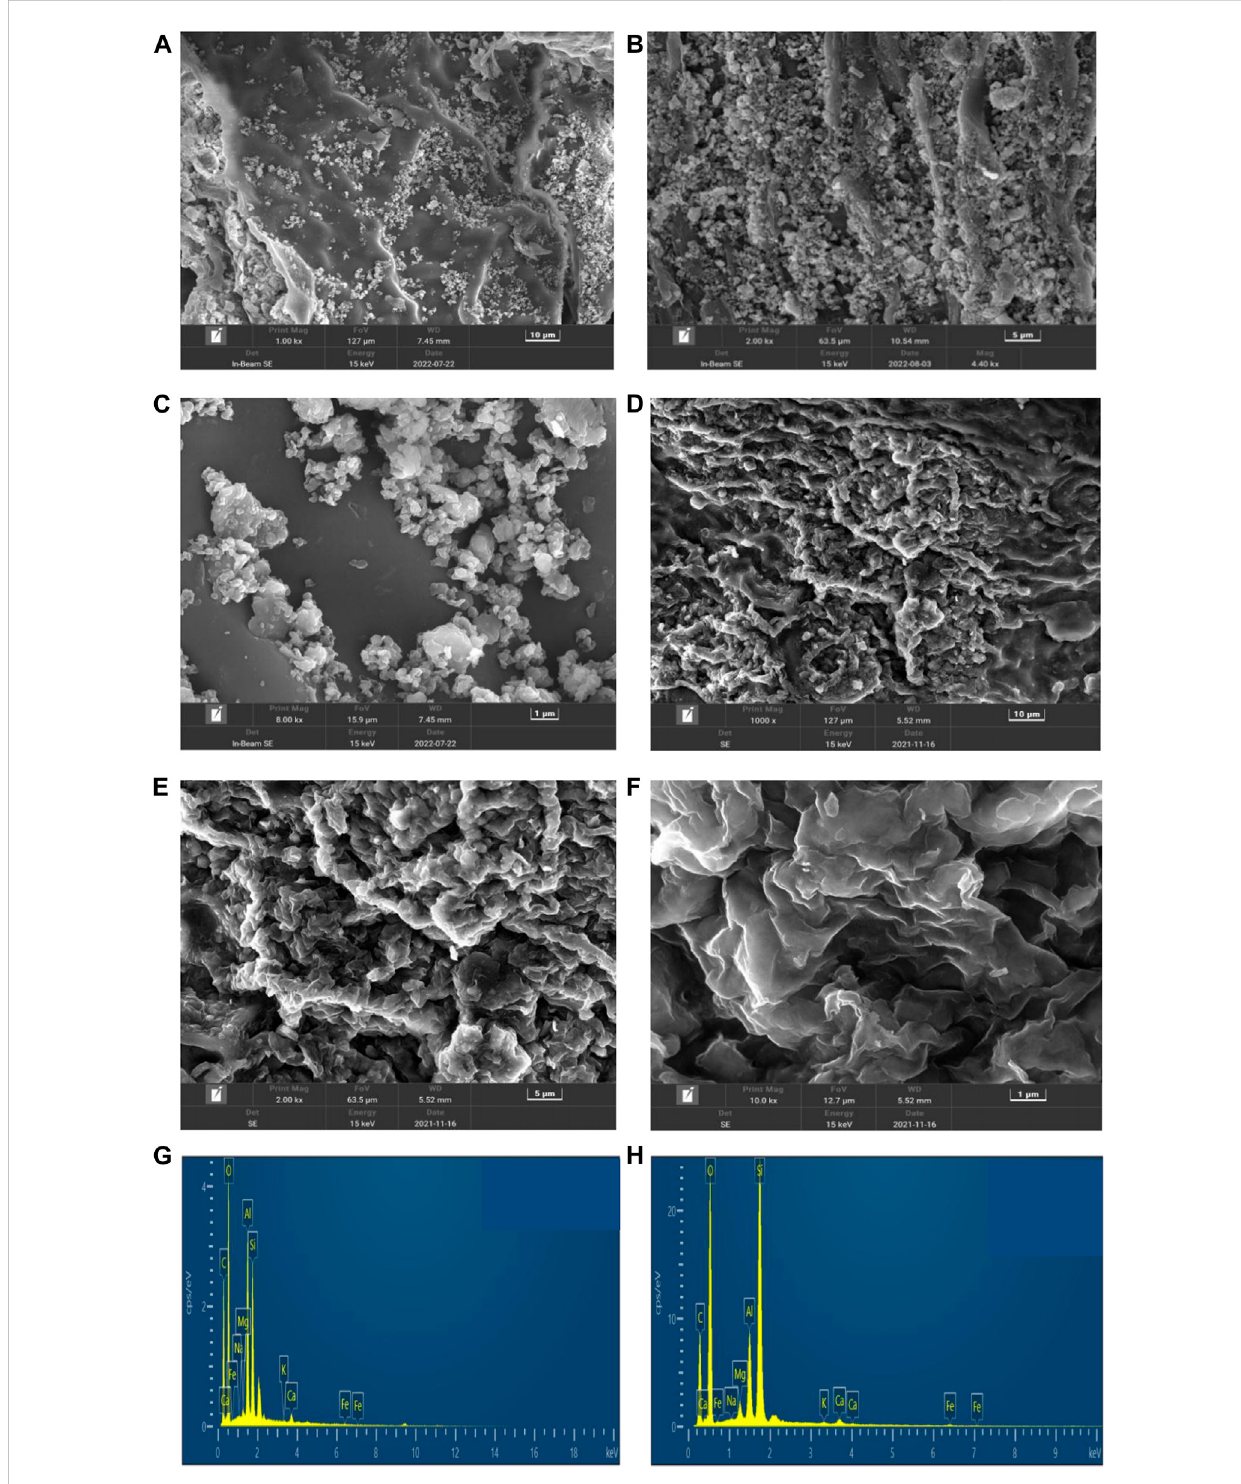
SEMimage (A – F) andEDXspectrum (G,H) ofthetwobiocharsamples: (A) KLN-TWBC,1,000×: (B) KLN-TWBC, 2000×; (C) KLN-TWBC, 8,000×, (D) MMT-TWBC,1,000×: (E) MMT-TWBC,2000×; (F) MMT-TWBC, 100,00×.TheEDSspectra (G,H) wereobtained atthesamelocationasshown intheSEM image (C, F) . KLN-TWBC, kaolinite modi fi ed tea waste biochar, and MMT-TWBC, montmorillonite modi fi ed tea waste